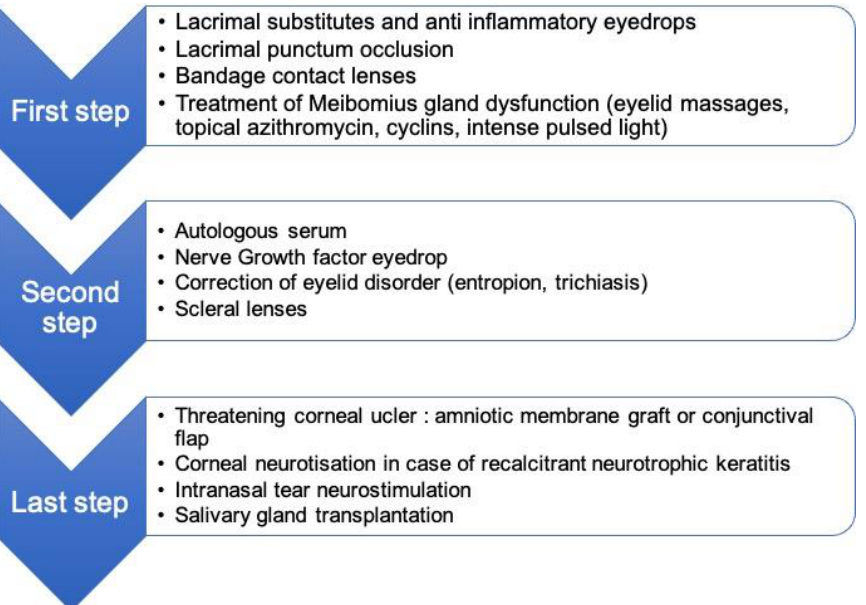
Figure 2. Treatment of radiation-induced dry-eye syndrome.